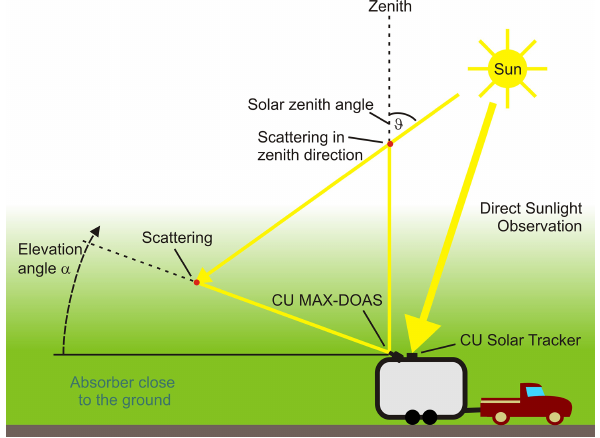
Figure 1. Illustration of measurement principle of the mobile solar tracker and the MAX-DOAS aboard the mobile laboratory deploy- ment during FRAPPE